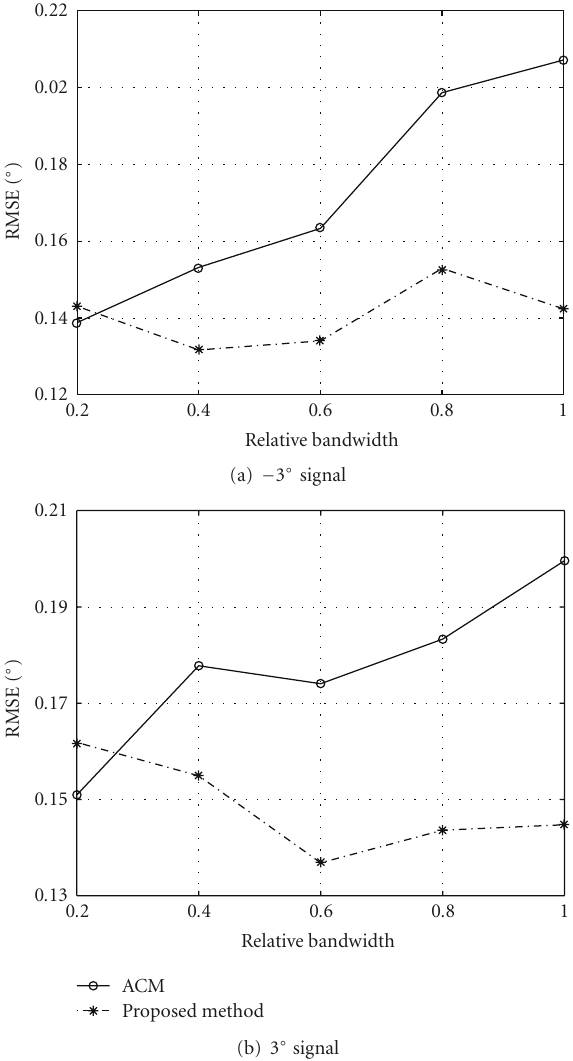
Figure 4: RMSE of the proposed method and ACM when two BPSK signals with baud rate of 10 MHz impinge onto the array.